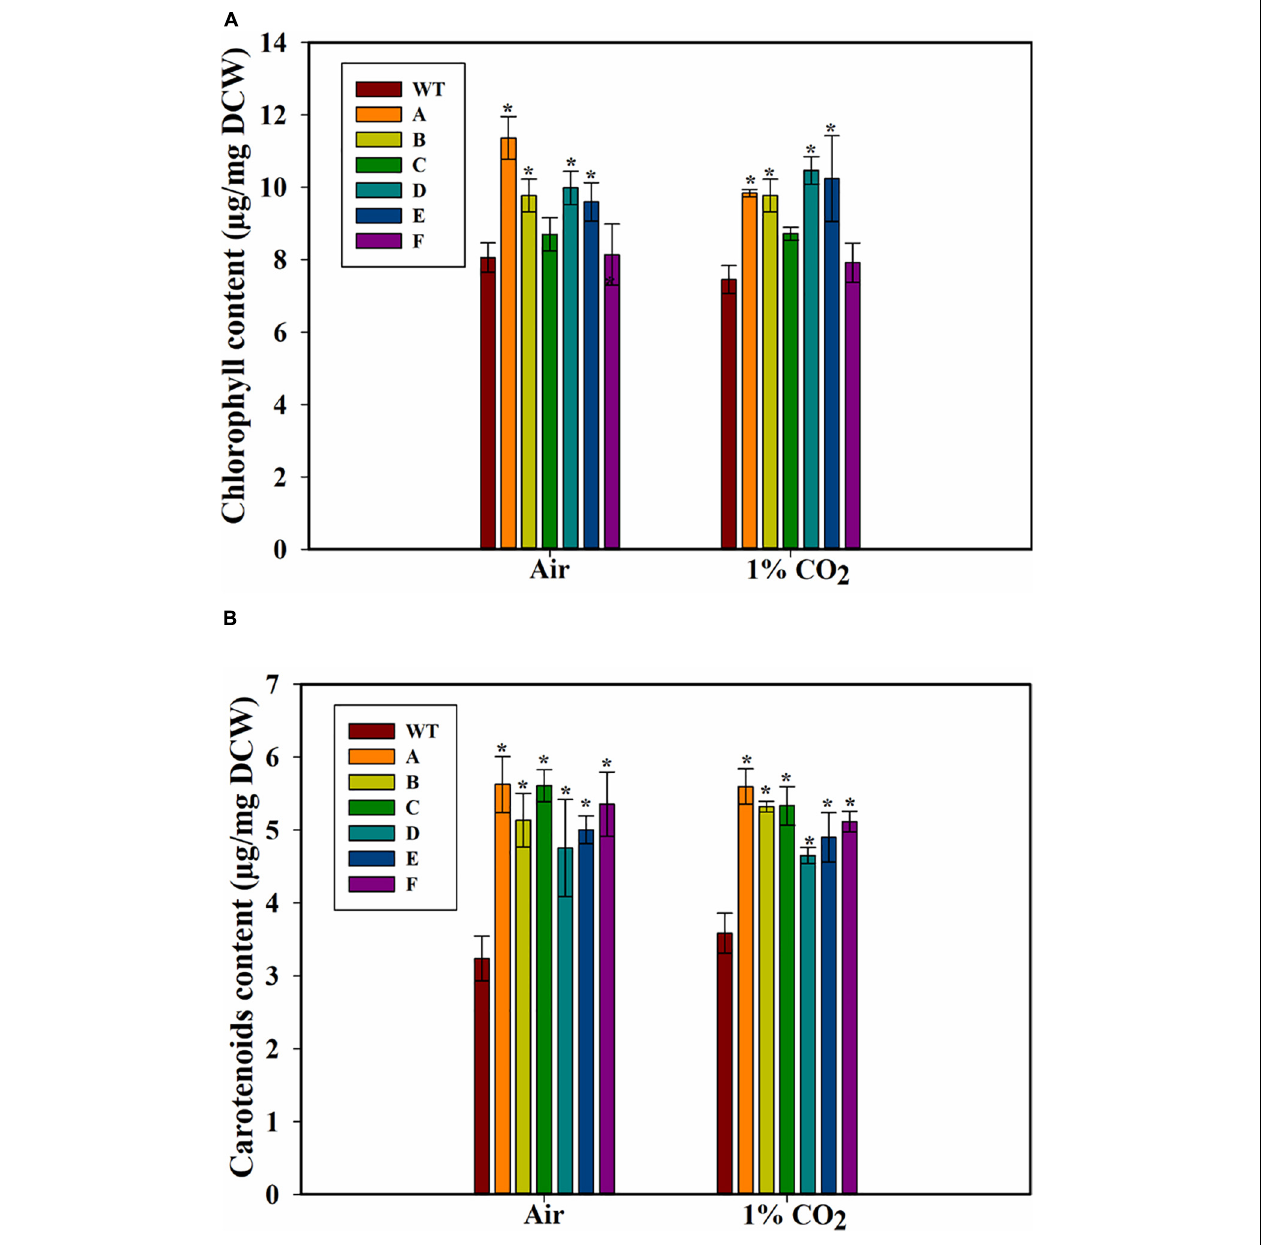
FIGURE 5 | Pigment content of wild type (PCC 7002) and transformants overexpressing SbtA with different promoters and RBSs (strains A to F) after 5 days of growth. (A) Chlorophyll content, and (B) carotenoids content, with the bubbling of air or 1% CO 2 . * p < 0.05 compared to WT PCC 7002 cells grown under similar CO 2 level, n =